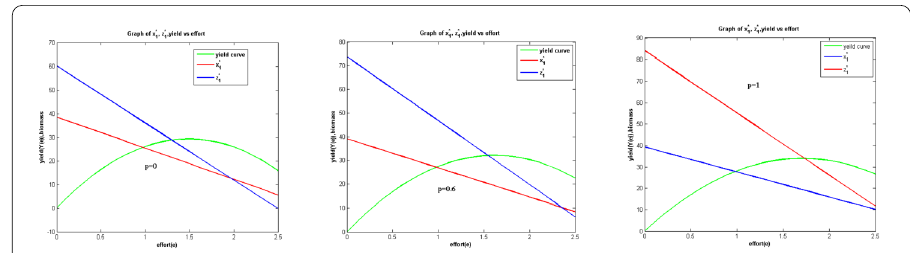
Figure 11 The changes in yield and population biomass with respect to the change in harvesting effort e in the range [0,2.5]. Here the value of parameter p has been varied in three different levels (the leftmost figure is for p = 0; the middle figure is for p = 0.6, and the rightmost figure is for p = 1)